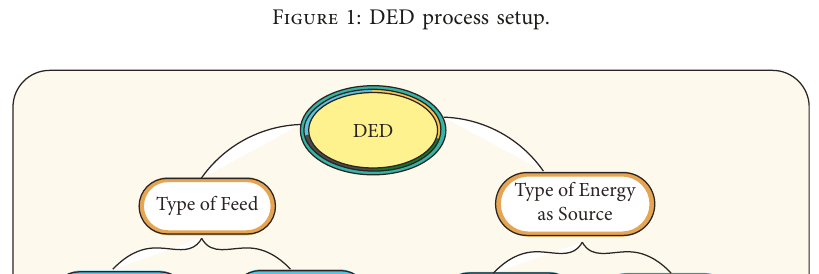
Figure 1: DED process setup.